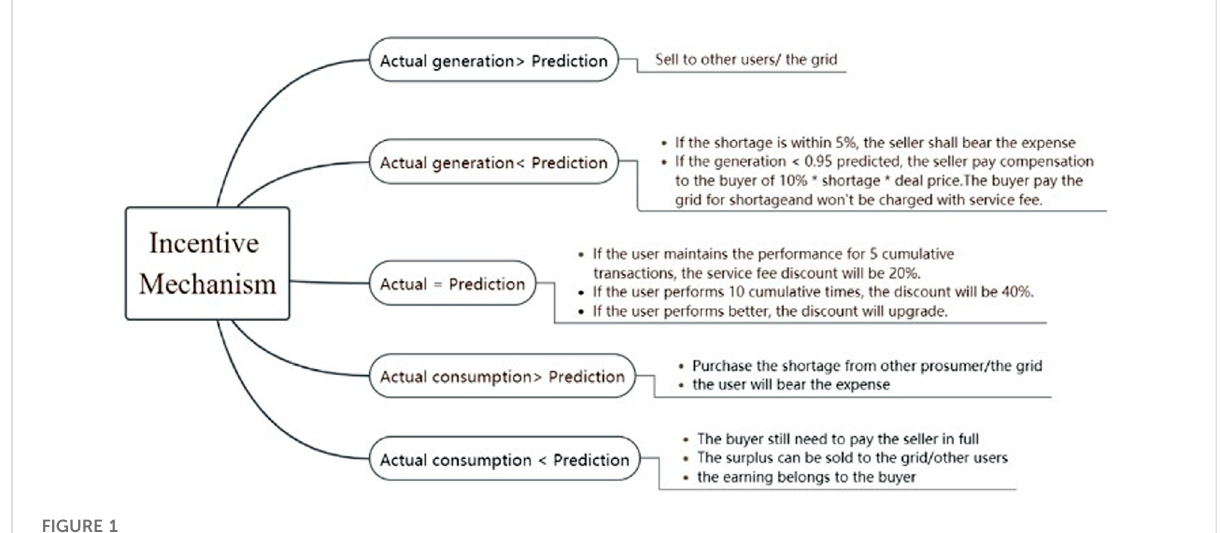
FIGURE 1 Illustration of incentive policy.